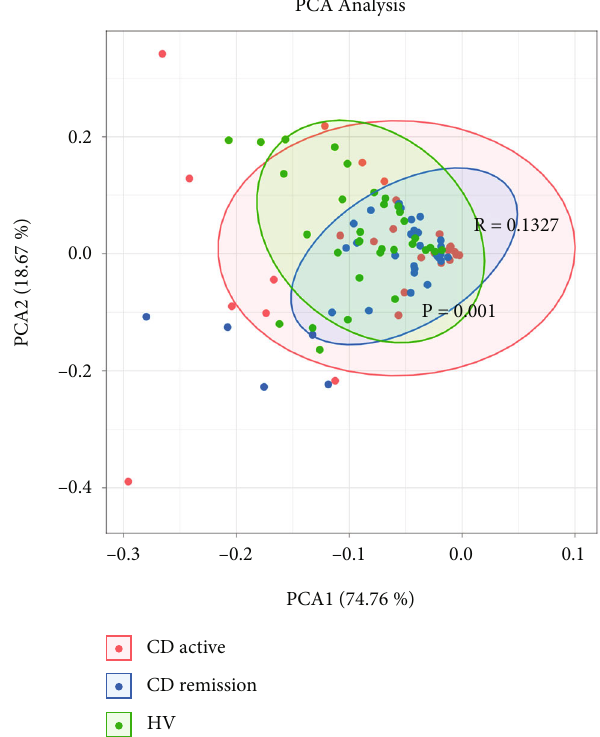
Figure 3: Principal component analysis (PCA) of bile acid pro fi le among three groups. CD active patients (red), CD remission patients (blue), and HVs (green) are